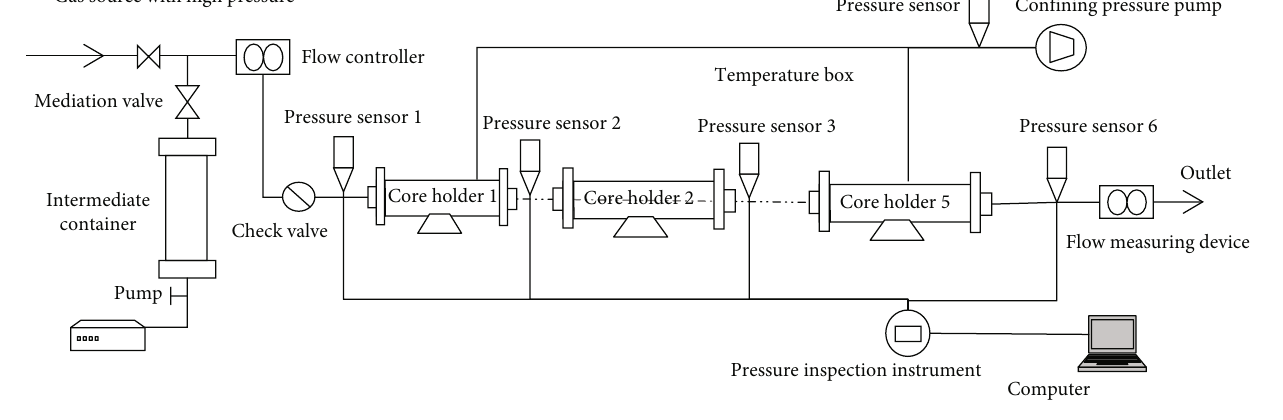
Figure 1: Flow chart of coupled fl ow experiment